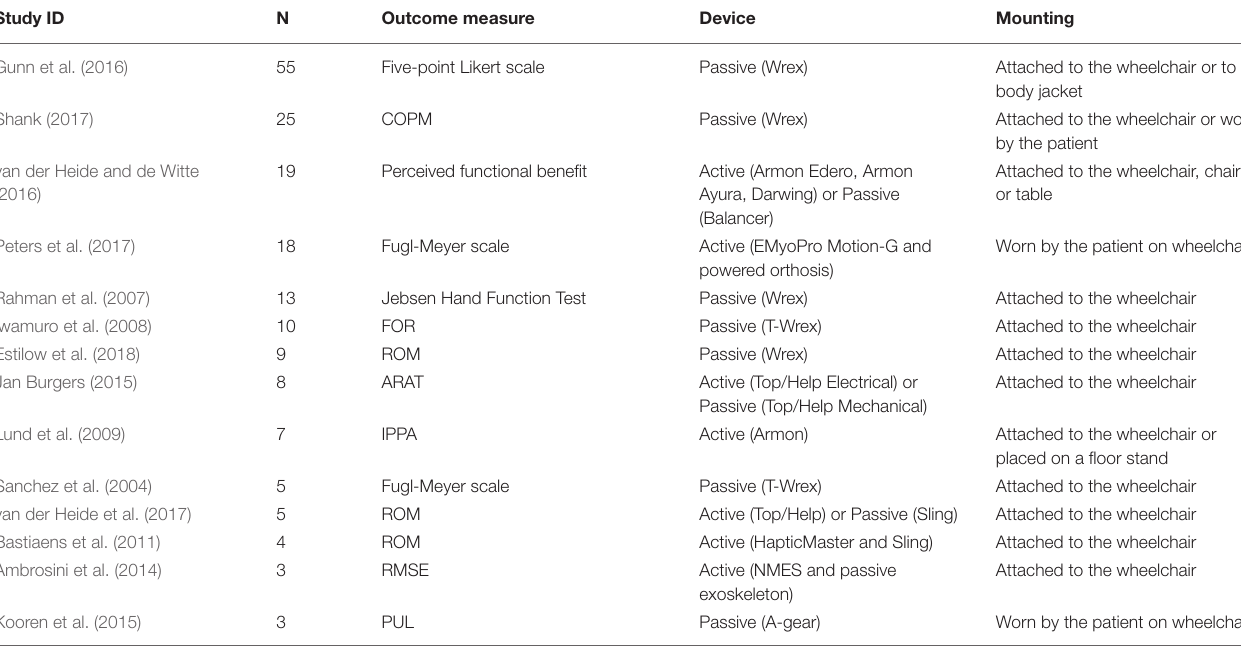
TABLE 3 | Details of study